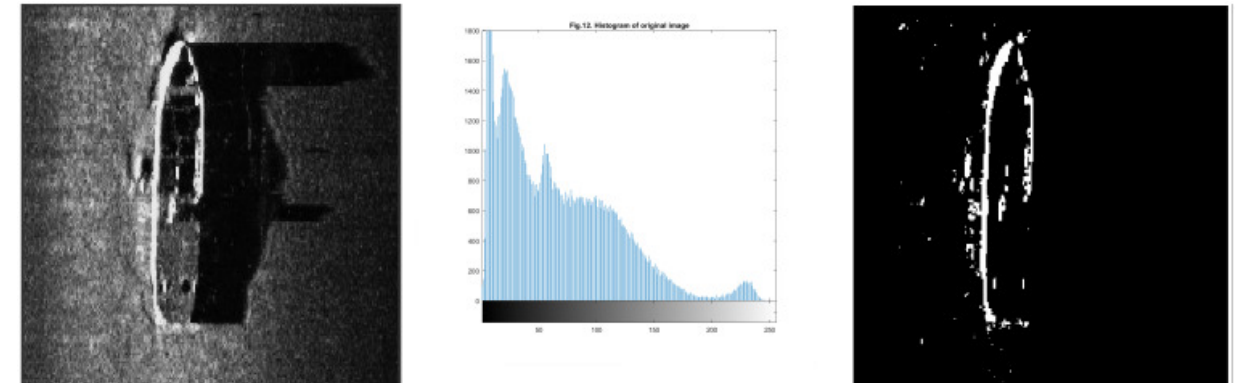
Figure 24. Results for test image Florida’s treasure coast.